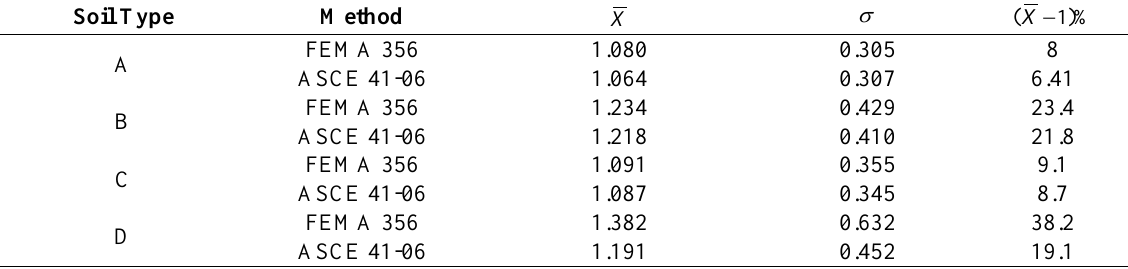
Table 8. The average values and standard deviations for soil